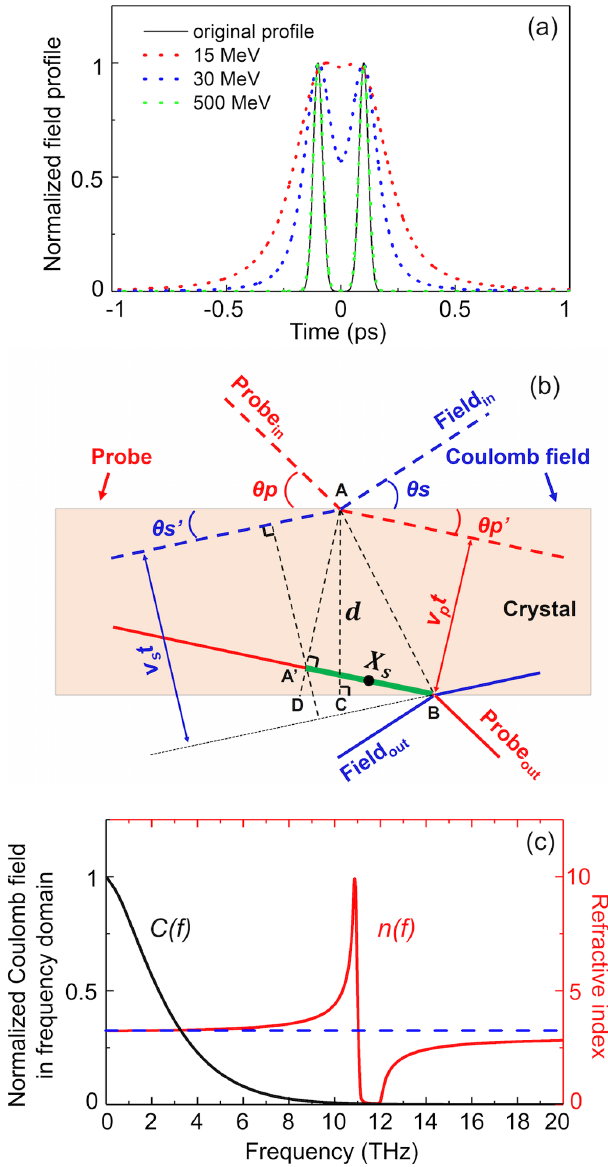
FIG. 7. Discussion on the limitation of EO spatial decoding. (a) Coulomb fields of a double bunch structure. The black curve is the original charge shape. Red, blue and green dotted lines denote the fields of 15 MeV, 30 MeV, and 500 MeV electrons, respectively. (b) Smearing process inside the EO crystal. “ A ” and “ B ” denote the beginning ( t ) and end ( t ) of the EO coding A B process. The blue dashed and solid lines show the peaks of the Coulomb fields at time t and t , while the red lines illustrate A B those of the probe laser. The crystal has a thickness of d . The green line denotes the smearing part of the signal with a length of X . The black dot at the center of the smearing part denotes the s peak of the EO signal. (c) The frequency domain Coulomb field of a 30 MeV, 20 fs electron bunch (black curve) and the refractive index of GaP crystal in the THz range (red curve). The blue 3 . 267 for dashed line denotes an average refractive index of ¯ n S ¼ the estimation of the propagation angle and phase velocity of the Coulomb field inside the